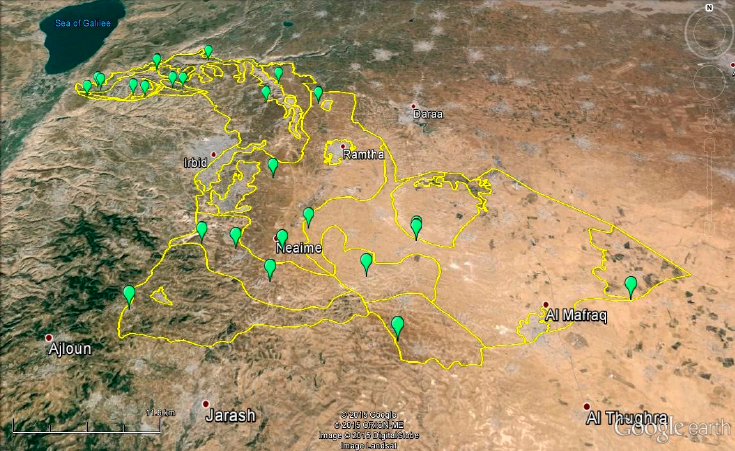
Figure 4. Google Earth image for the Yarmouk study area. The yellow line represents the border of LDUs and the green balloons represent the field work sites where we did the calibration for LDUs. The same method was used to calibrate the LDUs of the Wadi Mujib study area.